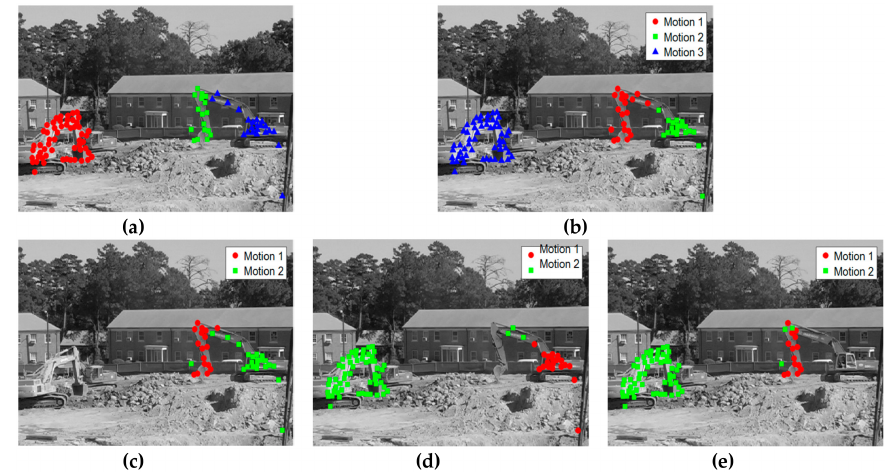
Figure 3. The results of motion segmentation on the two_cranes video sequence. ( a ) Ground truth of the two_cranes sequence, where the red dot represents the first motion model, the green dot represents the second motion model, and the blue dot represents the third motion model; ( b ) the segmentation result with three motions; ( c ) the segmentation result with two motions, which includes the second motion model and the third motion model; ( d ) the segmentation result with two motions, which includes the first motion model and the third motion model; ( e ) the segmentation result with two motions, which includes the first motion model and the second motion model.